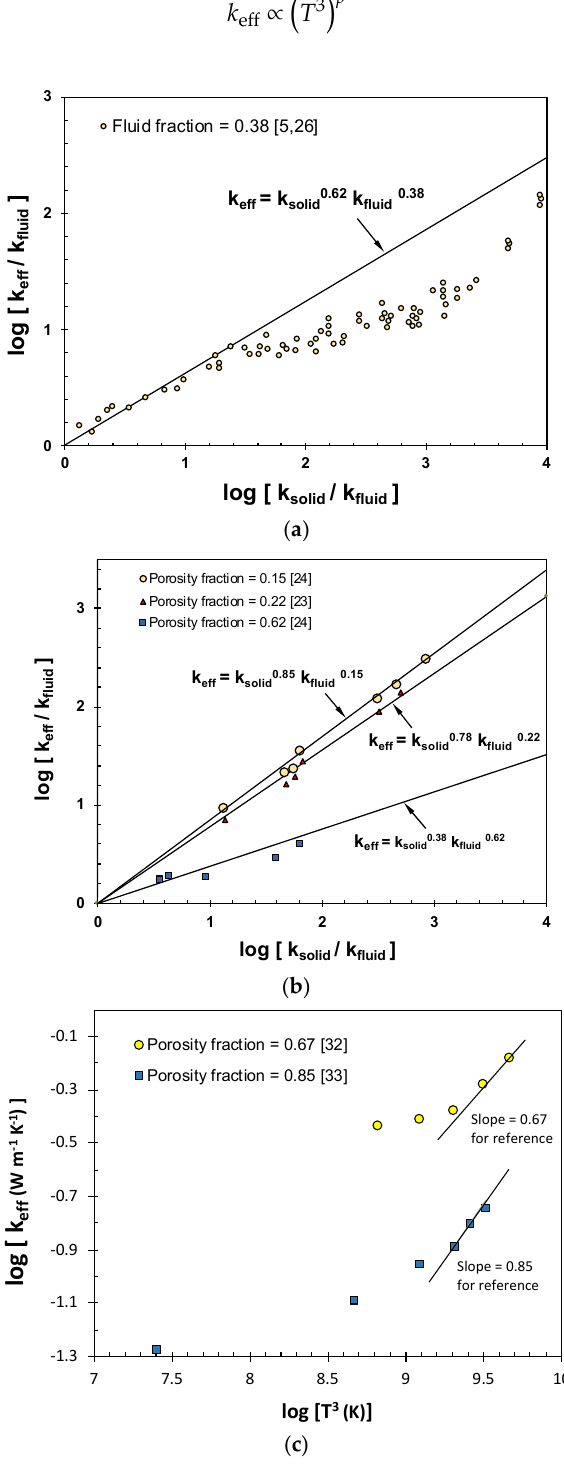
Figure 7. Comparison of logarithmic mixing rule with experimental data of ( a ) packed beds [5,26] ( b ) rocks [29,30] and ( c ) high temperature porous ceramics [38,39].